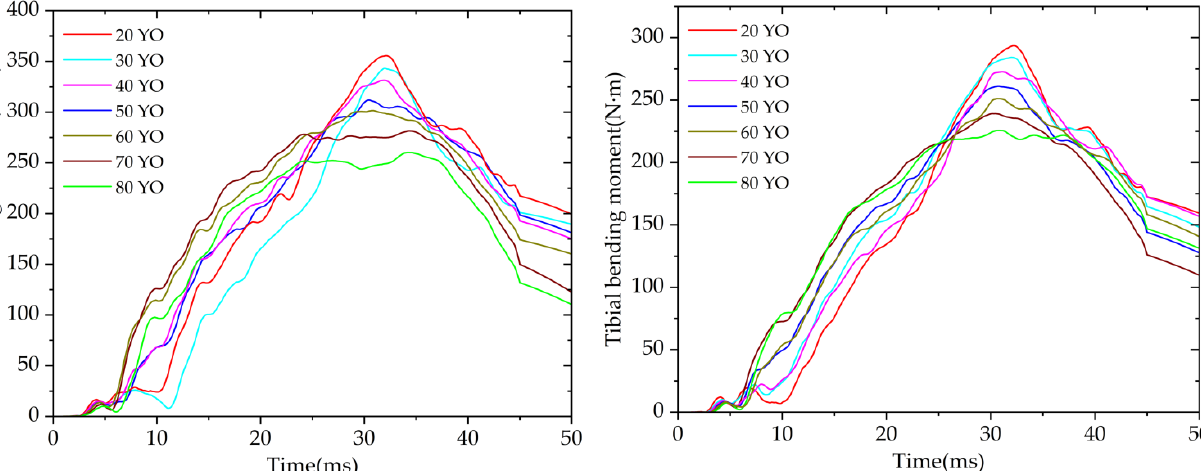
Figure A5. Bending moment of femur and tibia of pedestrians of seven ages at 70 km/h.